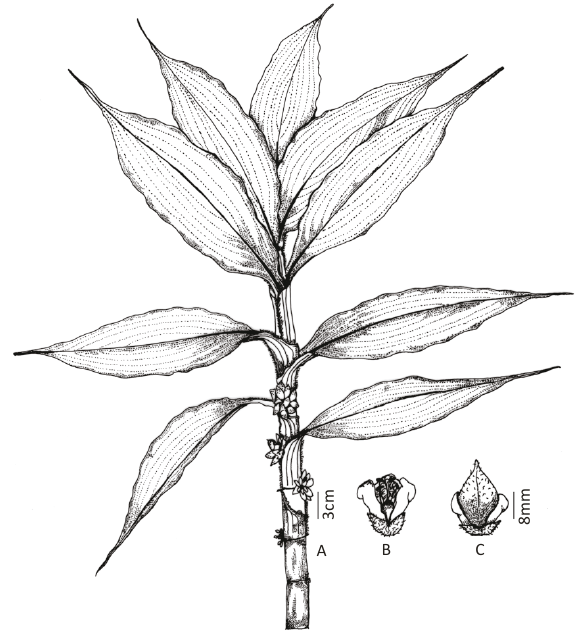
Figure 2. Amischotolype hookeri (cid:3)(cid:894)(cid:44)(cid:258)(cid:400)(cid:400)(cid:364)(cid:856)(cid:895)(cid:3)(cid:44)(cid:856)(cid:3)(cid:44)(cid:258)(cid:396)(cid:258)(cid:856)